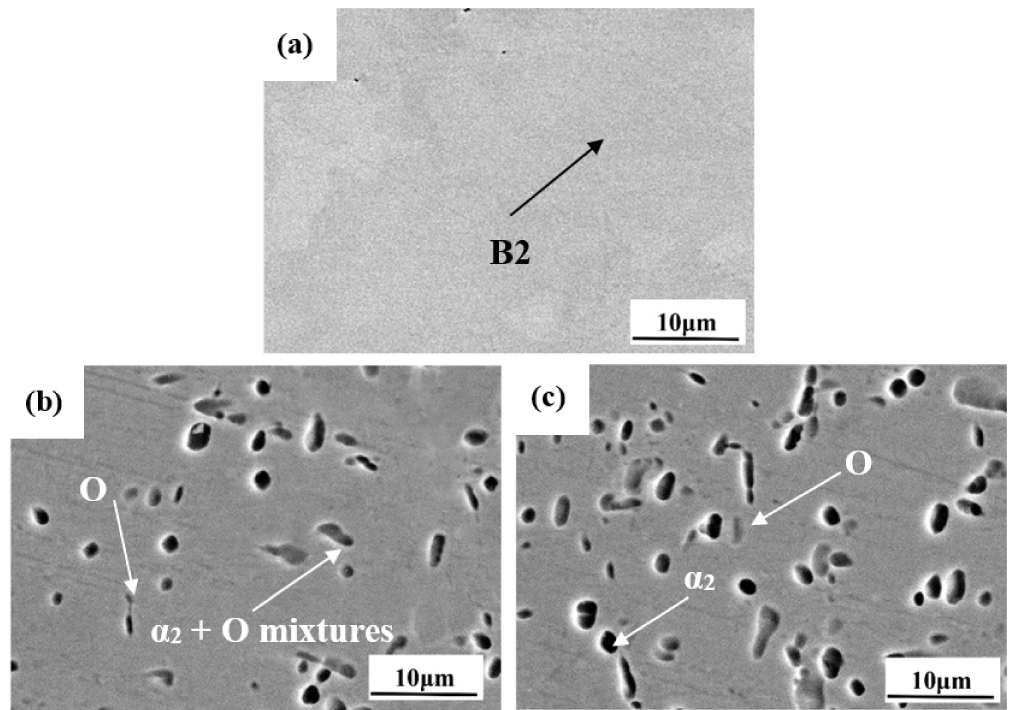
Figure 8. Microstructure of ( a ) weld zone, ( b ) near-weld zone in TMAZ, and ( c ) far-weld zone in TMAZ by SEM, respectively.